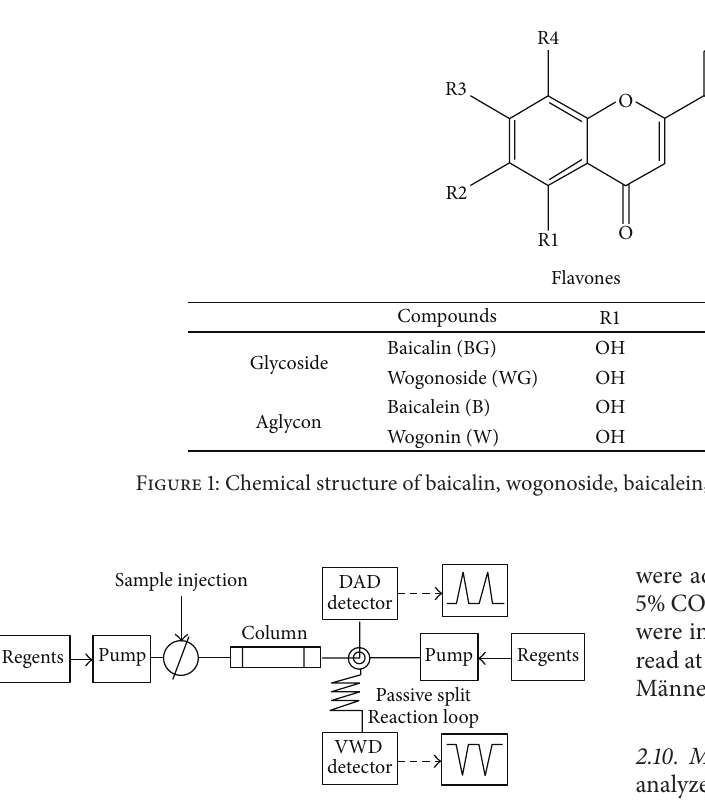
Figure 2: Schematic of online screening HPLC-ABTS system.